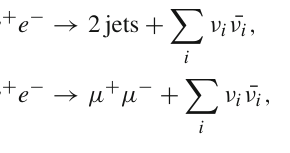
, (cid:15) E T , sum of energy of jet pairs 1